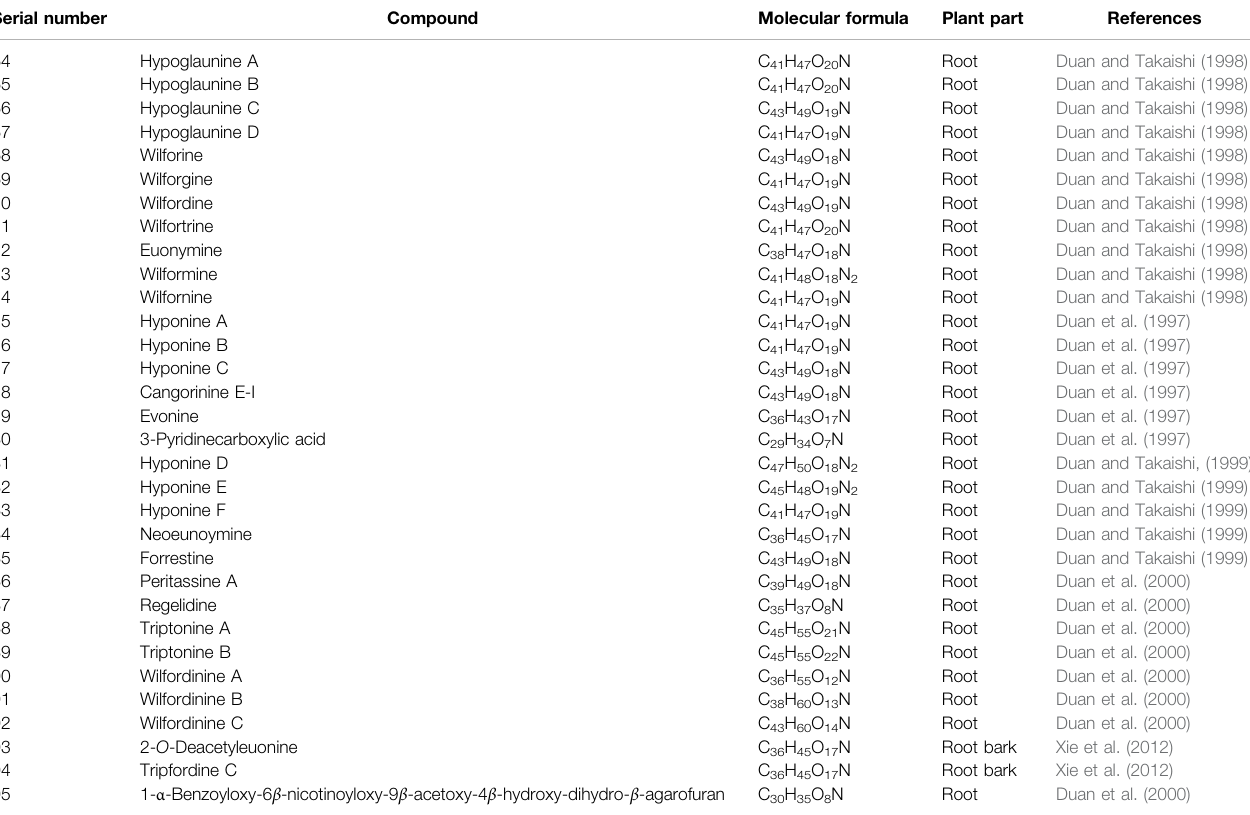
TABLE 3 | Alkaloids isolated from Tripterygium